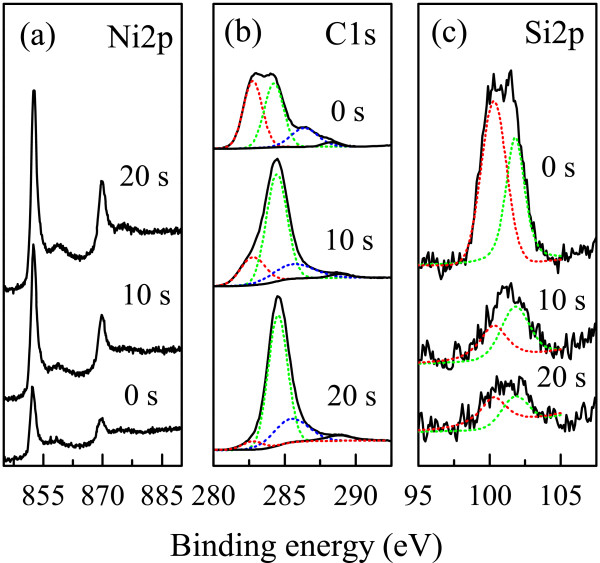
XPS of (a) Ni2p, (b) C1s, and (c) Si2pin Ni/(C, silicides) nanocapsules.